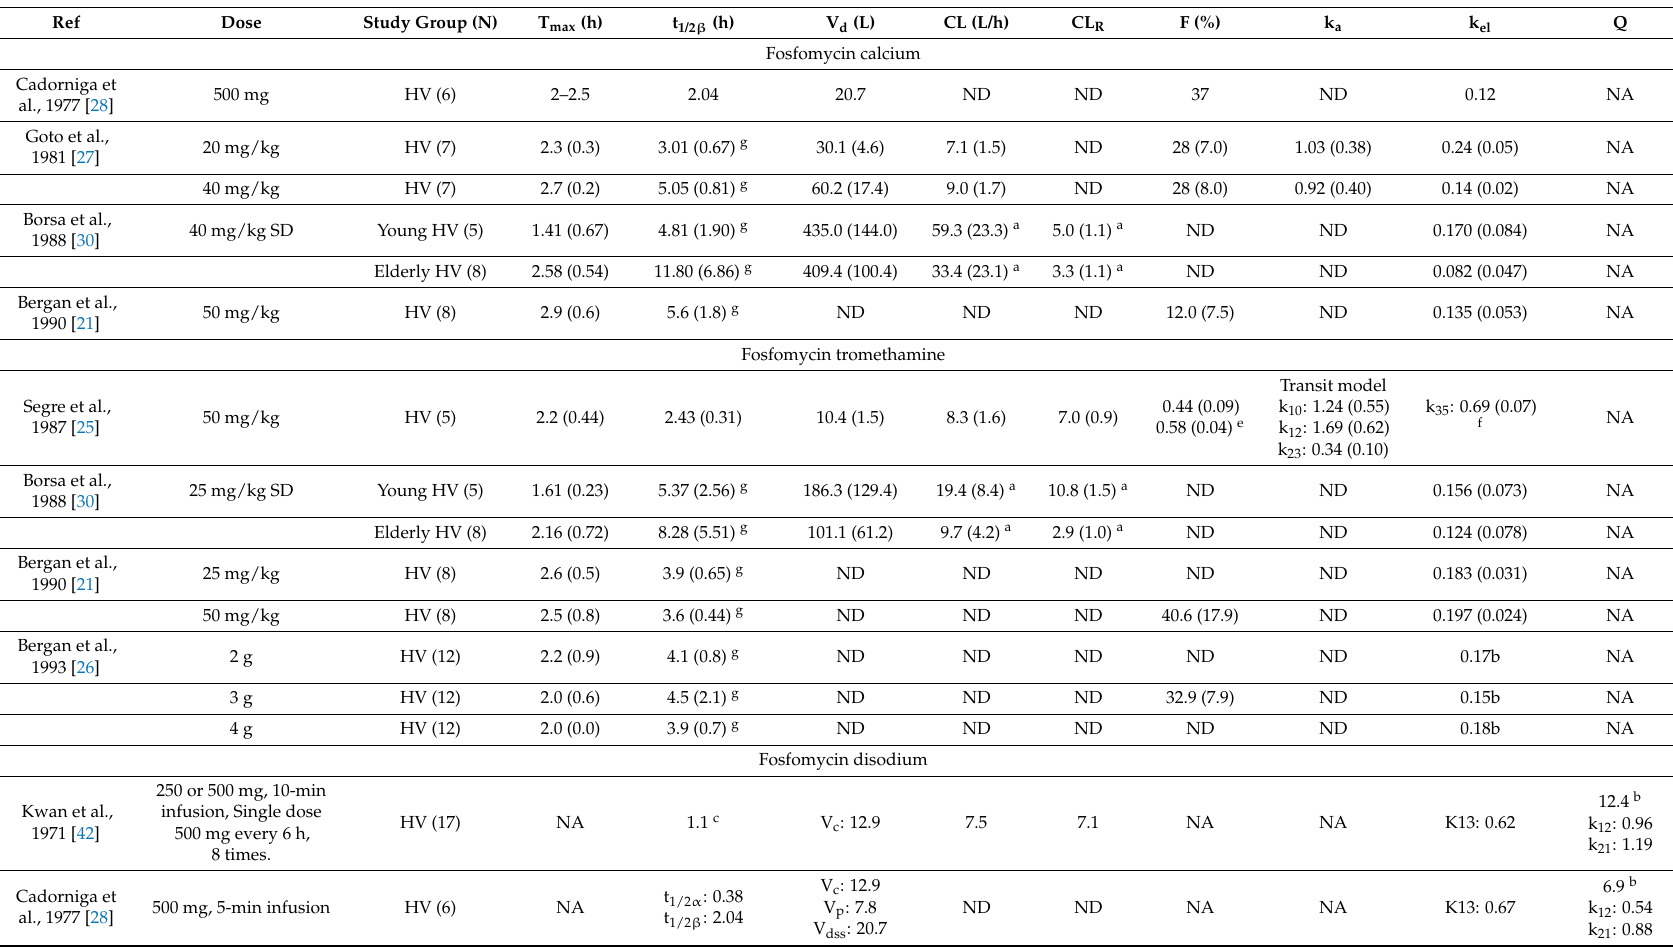
Table 1. Overview of the reported pharmacokinetic properties of fosfomycin calcium, fosfomycin tromethamine, and fosfomycin